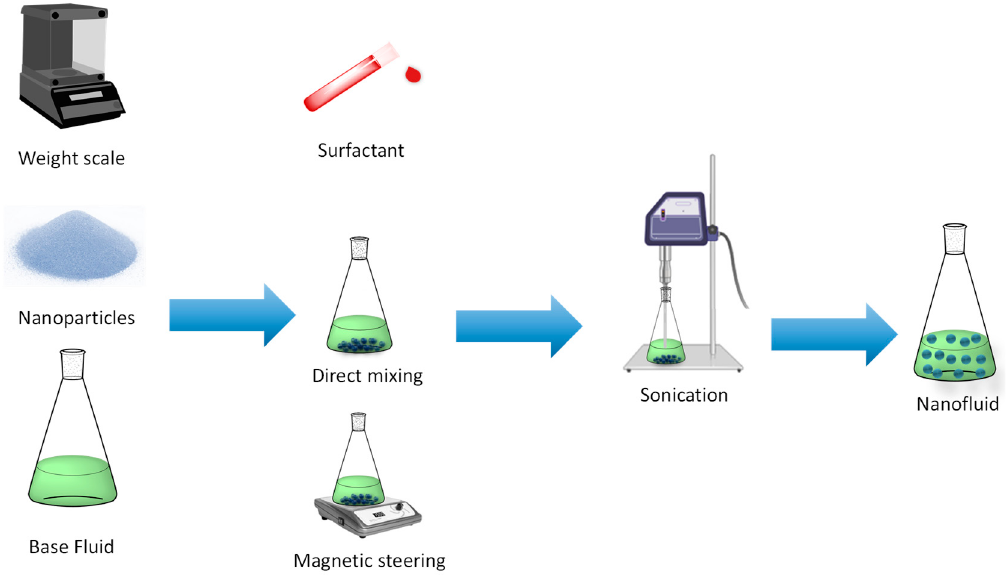
Figure 2. Two-step method.